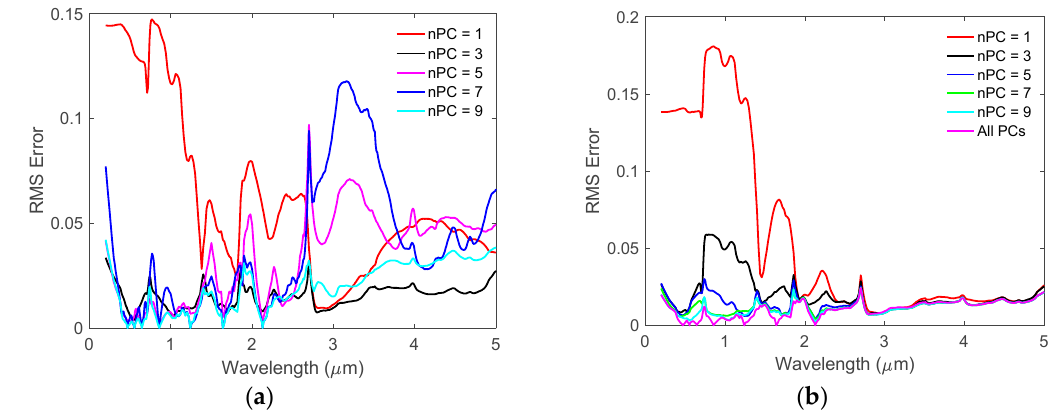
Figure 5. ( a ) The RMS errors of the simulated BRDFs using method described in [43,45]; ( b ) The RMS errors of the simulated BRDFs using HSBR model reported in this paper.